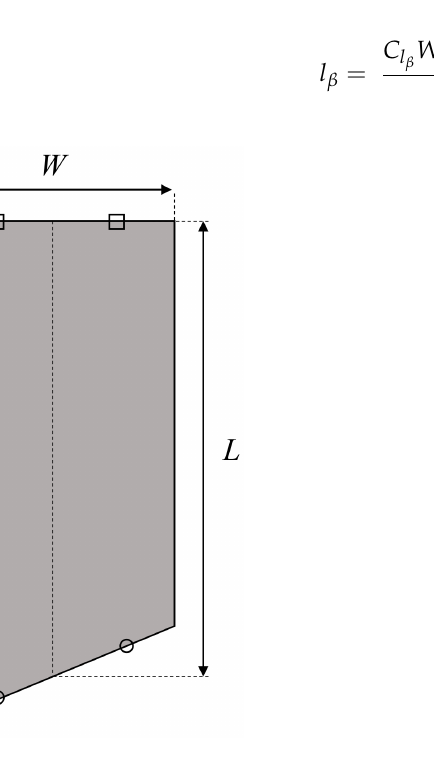
Figure 9. Representative